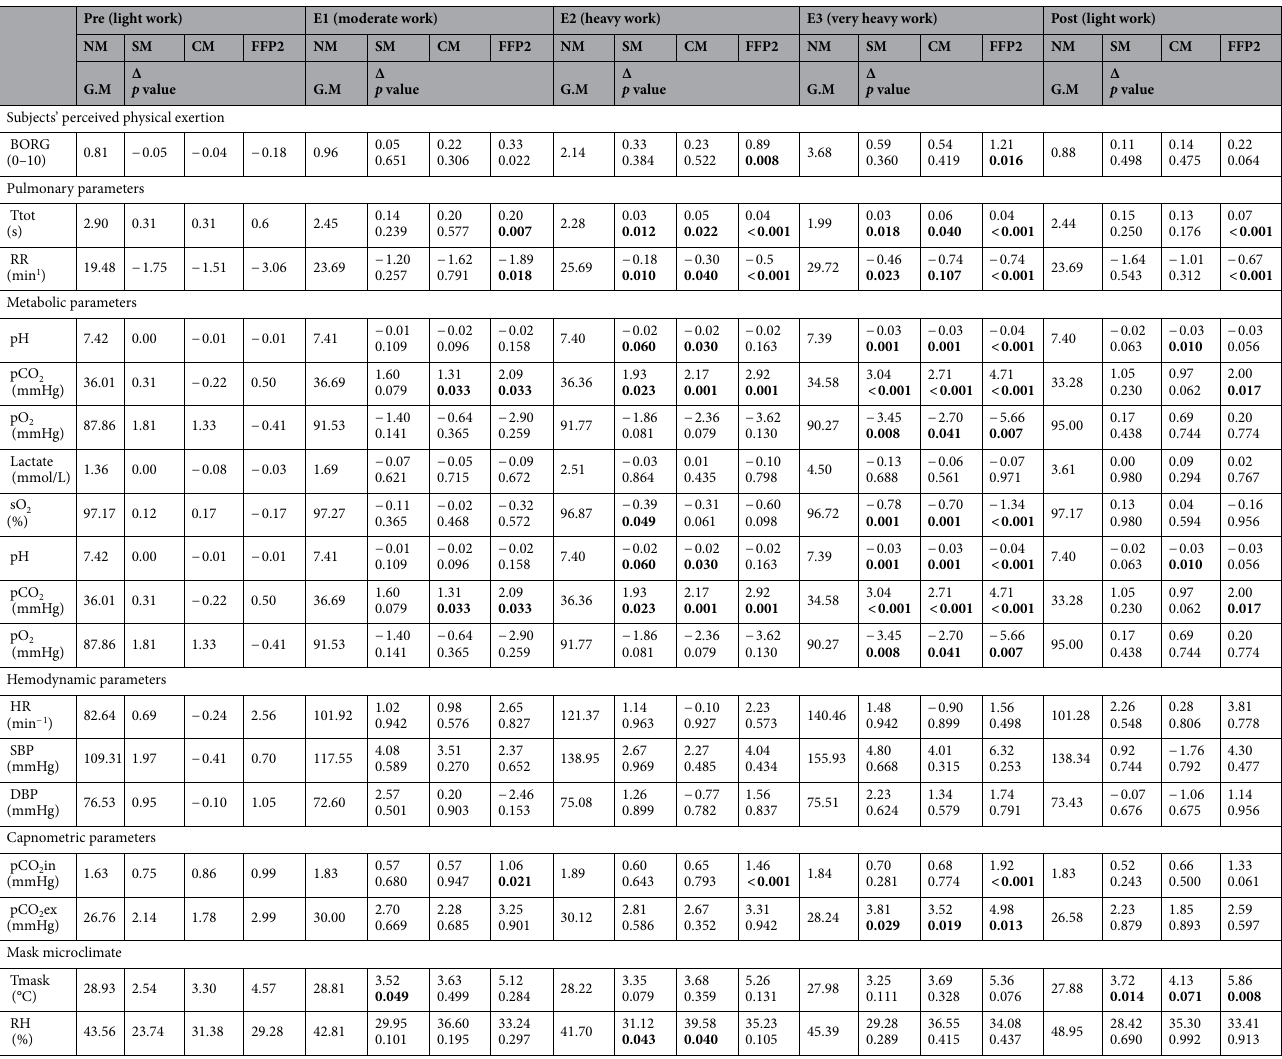
Table 4. Ergometry results of generalized linear mixed model (GLM model) analysis of 40 subjects without mask (NM) and with three different mask types (SM, CM, FFP2). BORG Borg scale, CM Community